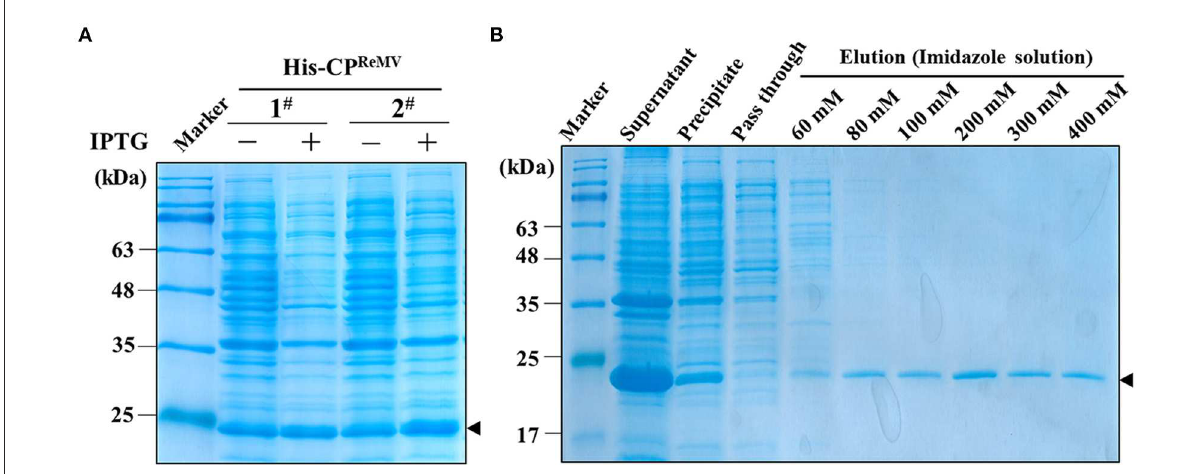
FIGURE1 Expression and purification of the recombinant His-CP ReMV protein in E. coli BL21 by affinity chromatography. (A) SDS-PAGE (12.5%) analysis the expression of His-CP ReMV protein in two independent E. coli BL21 transformants (1#, 2#), which showing the expression levels of target